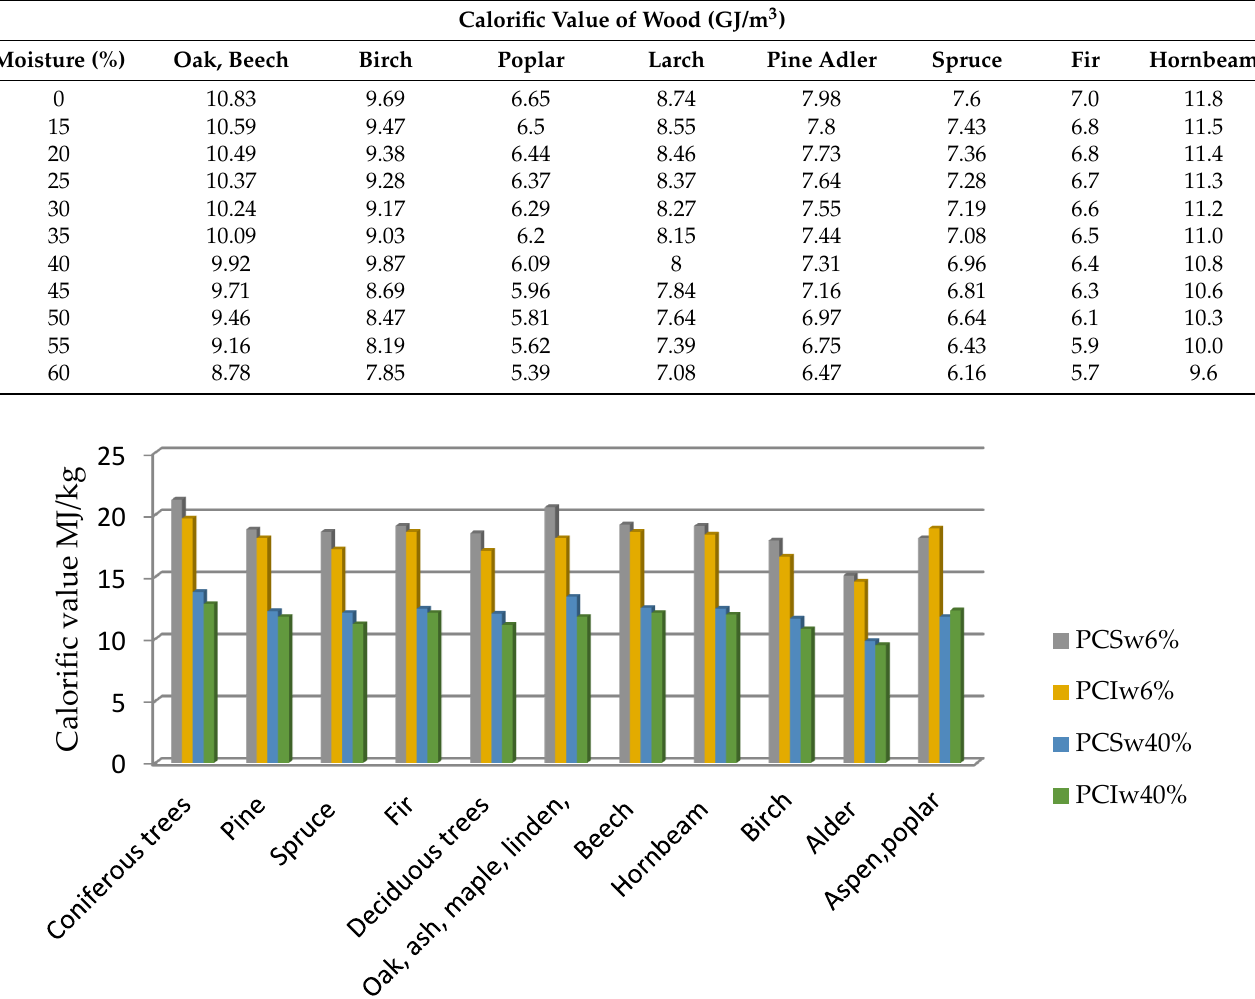
Table 3. Calorific value of wood in GJ depending on the moisture content of the wood species per unit volume [110,111].